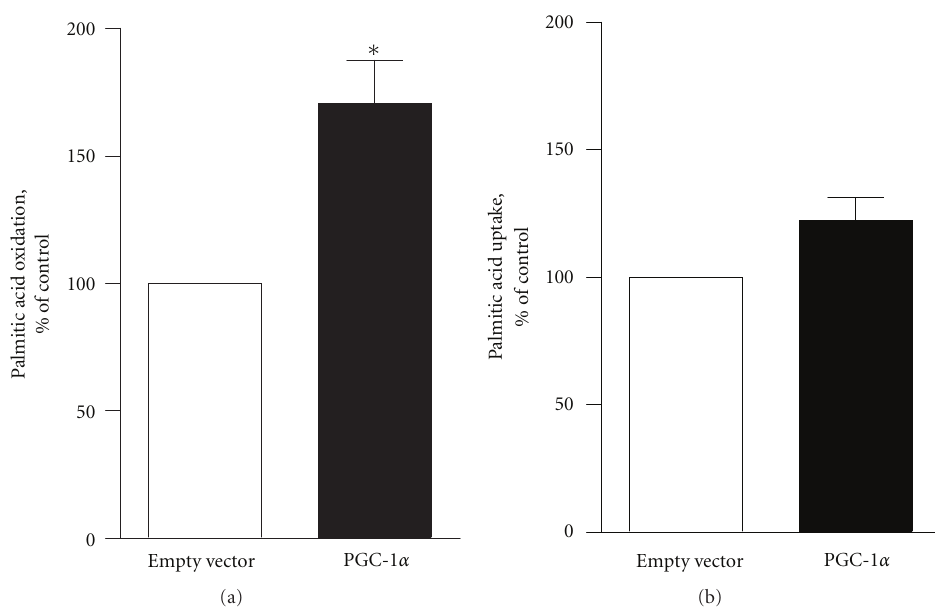
Figure 3: E ff ects of PGC-1 α overexpression on palmitic acid oxidation (a) and uptake (b) in human myotubes. Myotubes infected with either empty vector or PGC-1 α were incubated with [ 3 H]palmitic acid and assayed for labeled acid soluble metabolites (ASM), as described in Section 2. (a) Values are presented as means ± SEM ( n = 4 experiments, representing 3 di ff erent donors; with 3 replicates each). (b) Values are presented as means ± SEM ( n = 3 experiments, representing 2 di ff erent donors; with 3 replicates each). ∗ Significantly di ff erent from empty control vector at P < 0 . 05.